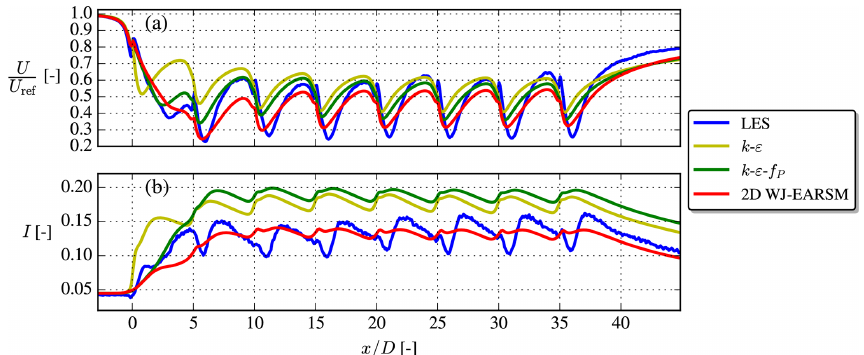
Figure 23. Streamwise velocity and turbulence intensity at the axial line going through the AD centers for the aligned-row TotalControl